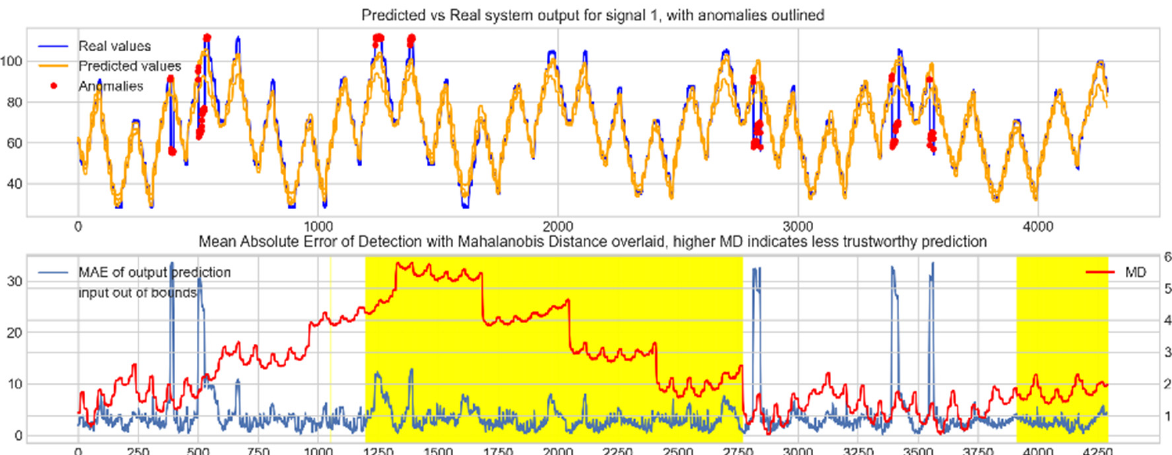
Figure 10. Predicted vs. real device output for signal 1, the right elevon, with anomalies labelled ( top ); MAE, MD and boundary check corresponding with the prediction ( bottom ). The yellow shaded areas represent new inputs outside expected input space.